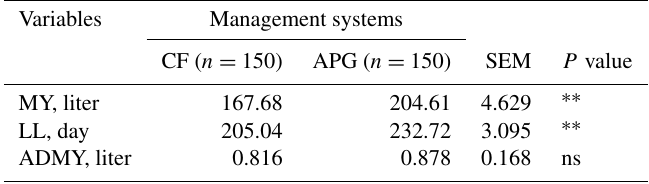
Table 1. Milk yield and lactation length of the Awassi ewes of the different management systems. Variables Management systems